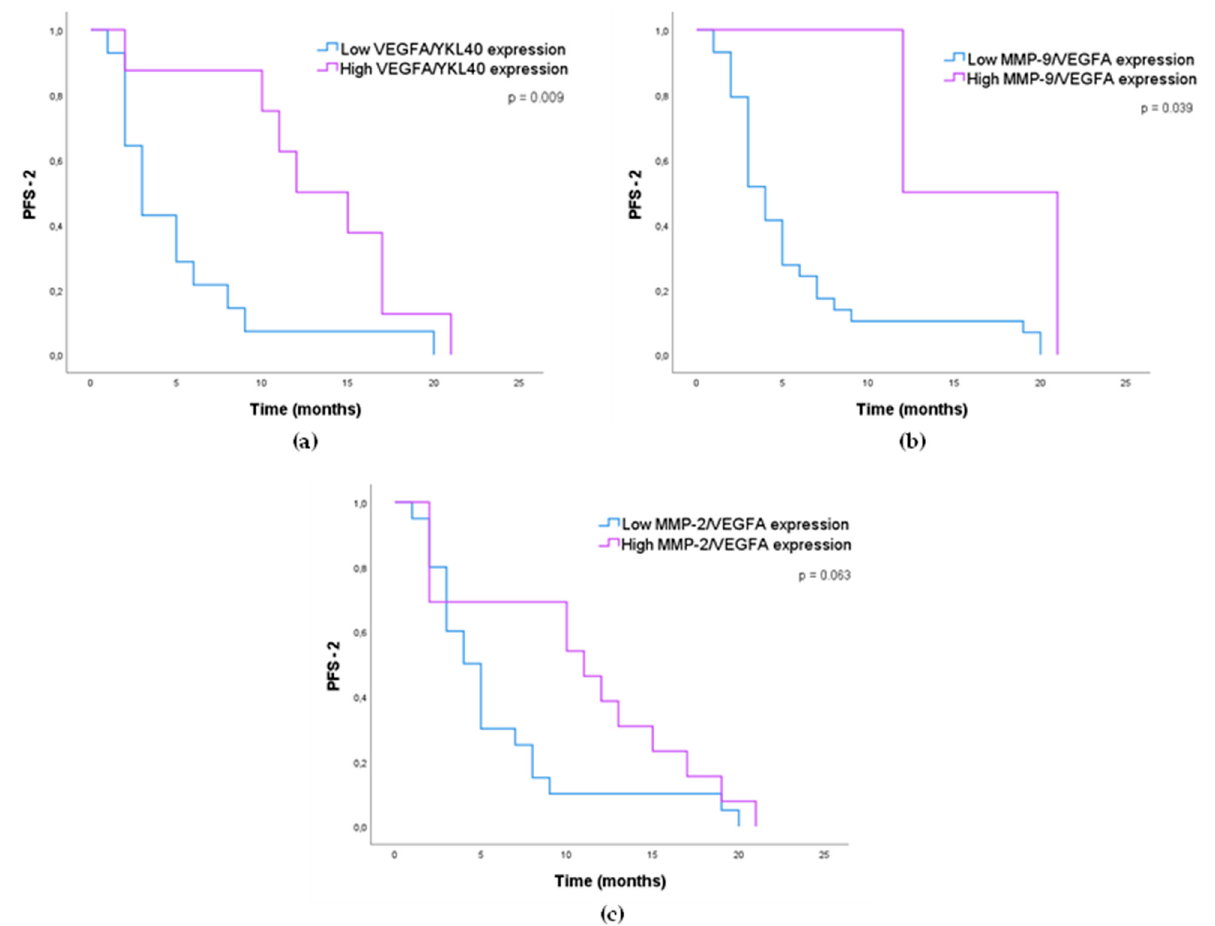
Figure 3. Kaplan–Meier analysis of progression-free survival (in months) after bevacizumab treat- ment (PFS-2) according to the concomitant expression of VEGFA with YKL40 ( a ), MMP-9 ( b ), and MMP-2 ( c ).